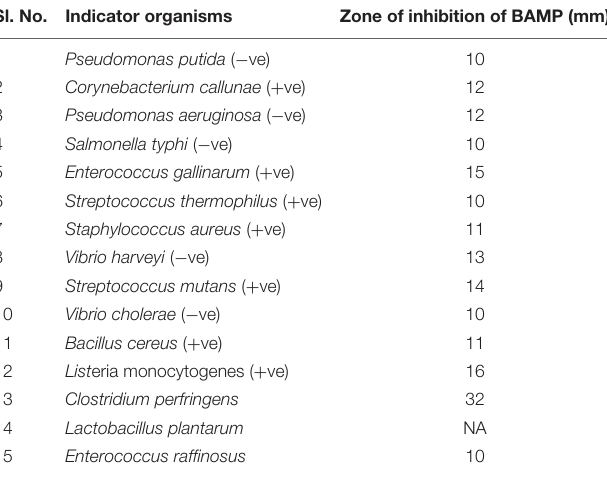
a well-diffusion assay by using various Gram-positive and